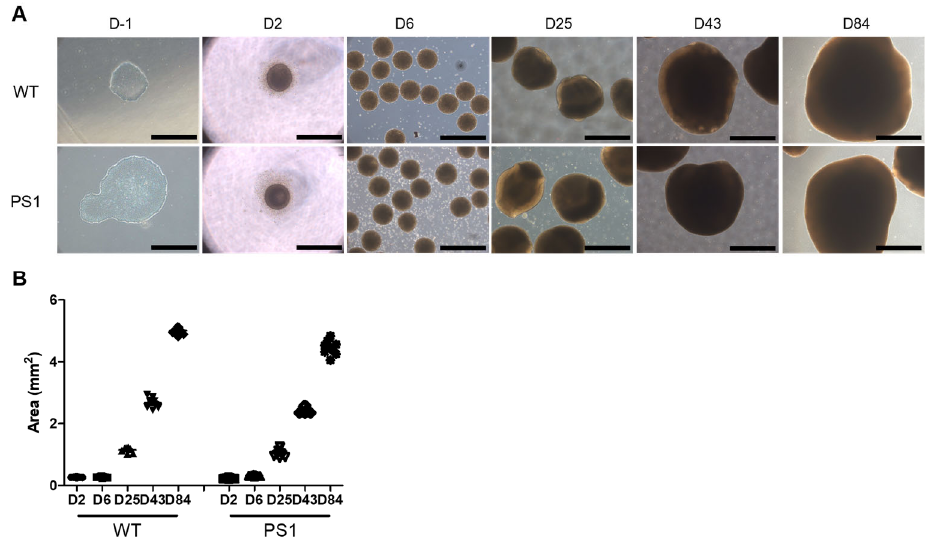
Figure A1. WT and PS1 cortical organoid neurogenesis. ( A ) Images of WT and PS1 cortical organoid neurogenesis, starting from iPSC to d84 matured organoid. Scale bar, 1 mm. ( B ) Area measured of WT and PS1 cortical organoid at different stages. n = 10, each data point represents a single organoid at a specific timepoint.